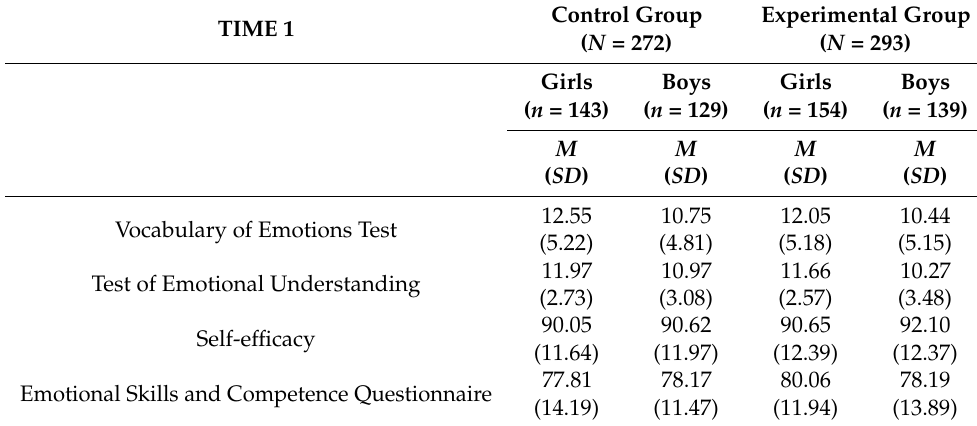
Table 3. Pre-test means and standard deviations for girls and boys in the experimental and control group at baseline (first measurement point).